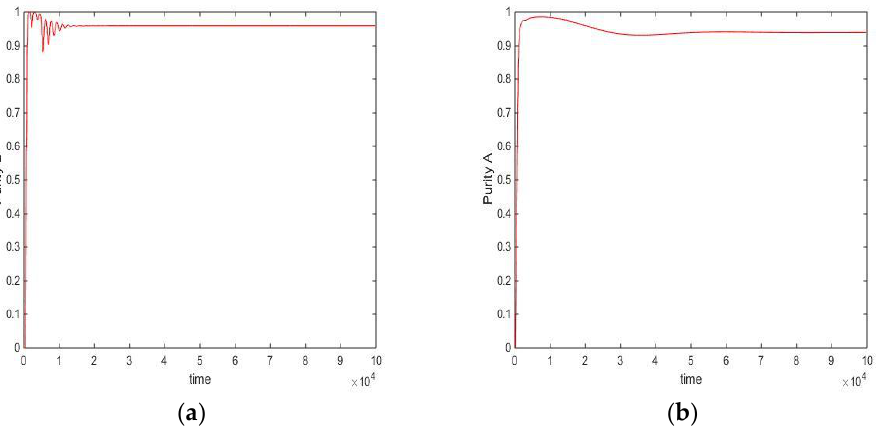
B = 96%). ( a ) Extraction outlet (material B); ( b ) raffinate outlet (material A).